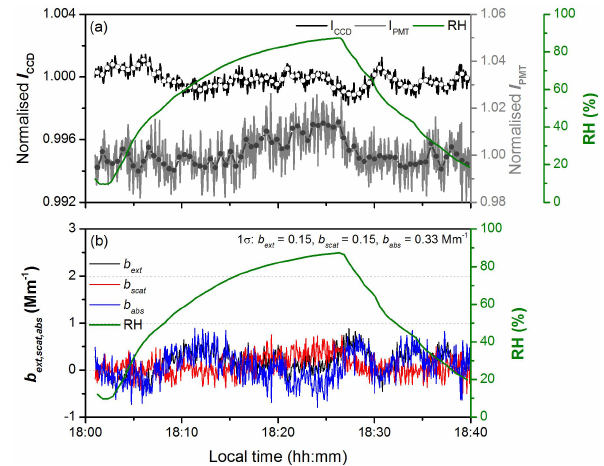
Figure 4. Influence of water vapour on measurement of b ext , b scat , and b abs . (a) Time series variations of the relative changes of I CCD and I PMT , and (b) the corresponding b ext , b scat , and b abs values of wet zero air during an RH cycle ranging from 10% to